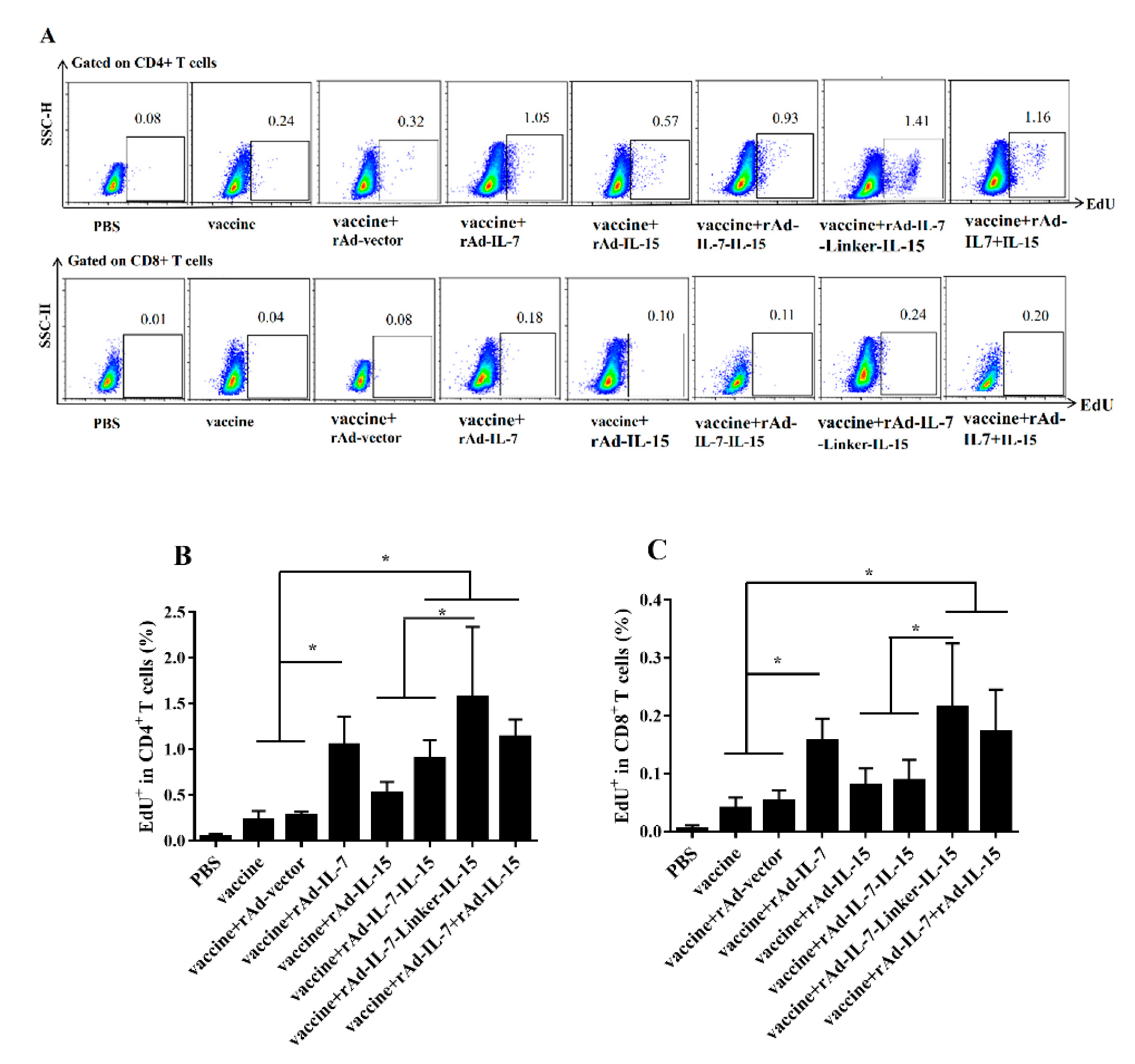
Figure 4. Proliferative capability of lymphocytes. For proliferation assay, 20 weeks after the last vaccination, lymphocytes (5 × 10 6 cells/well) were stimulated with a cocktail of antigens ESAT-6, Ag85B, Rv2626c and HspX (2 μ g/mL) for 7 days in 24-well plates. Three days after antigen stimulation, EdU was added at a final concentration of 30 μ M and cells were cultured for another 4 days. At the 7th day, proliferative cells were detected by flow cytometry. ( A ) The representative results of every group. ( B ) Frequency percentages of EdU+ in CD4 + T cells; ( C ) Frequency percentages of EdU+ in CD8 + T cells. Results are presented as means ± SD from groups of 5 mice. * p < 0.05.